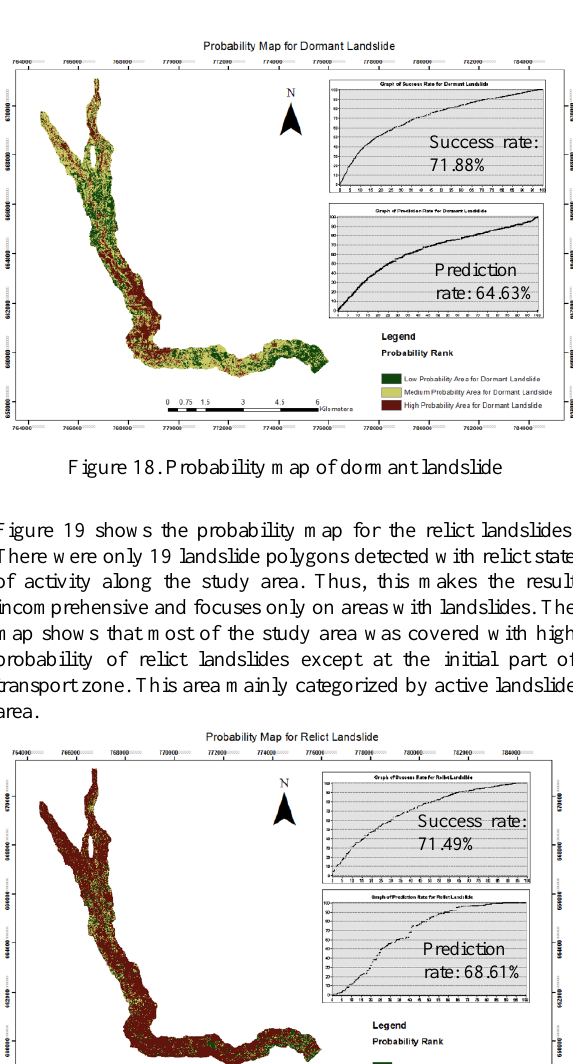
Figure 19. Probability map of relict landslide The landslide probability map based on different type and state of activity also were derived using bivariate approach.